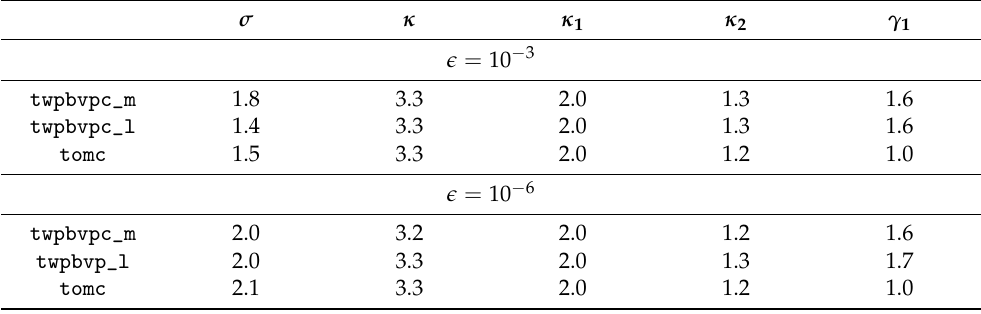
Table 14. Bang-Bang optimal control problem: conditioning parameters computed using tol = 10 − 6 .